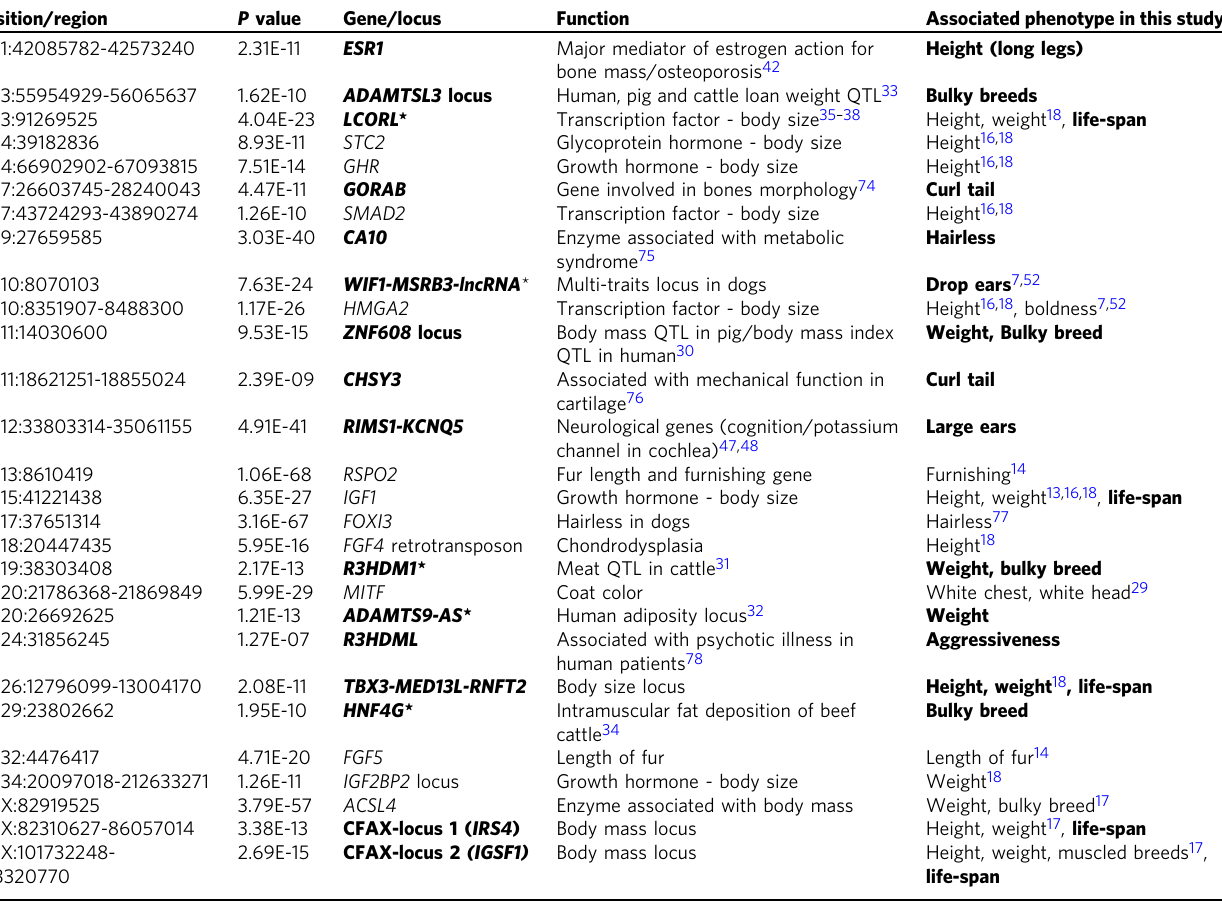
Bold indicates identi fi cation in this study, and asterisk denote previously unreported mutations Region or exact positions are de fi ned by variants passing the Bonferroni correction threshold